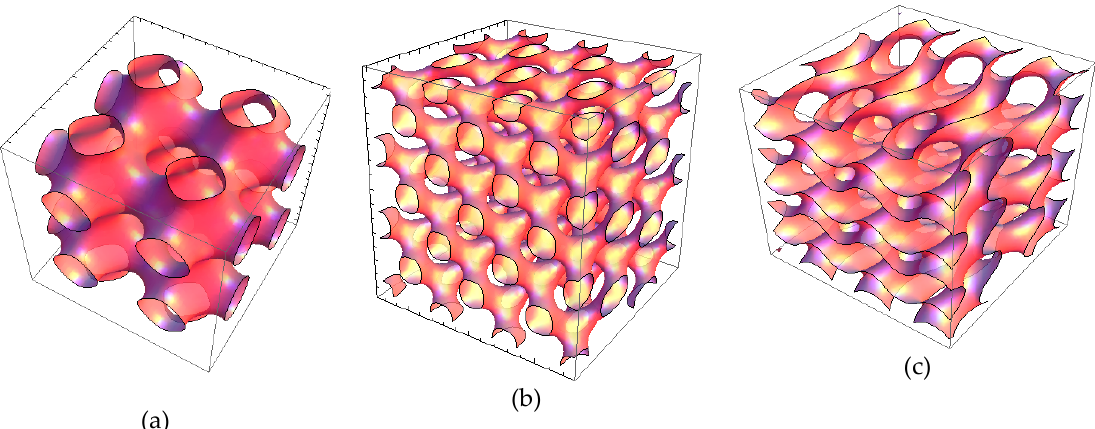
Figure 1. Three-dimensional organizations of cubic liquid crystalline phases: ( a ) Primitive cubic referred to as Im3m / Q IIP ), ( b ) bicontinuous double diamond cubic ( Pn3m / Q IID ), and ( c ) bicontinuous (also referred to as Im3m /Q IIP ), ( b ) bicontinuous double diamond cubic ( Pn3m /Q IID ), and ( c ) gyroid cubic ( Ia3d / Q IIG ) bicontinuous gyroid cubic ( Ia3d/ Q IIG ) types.